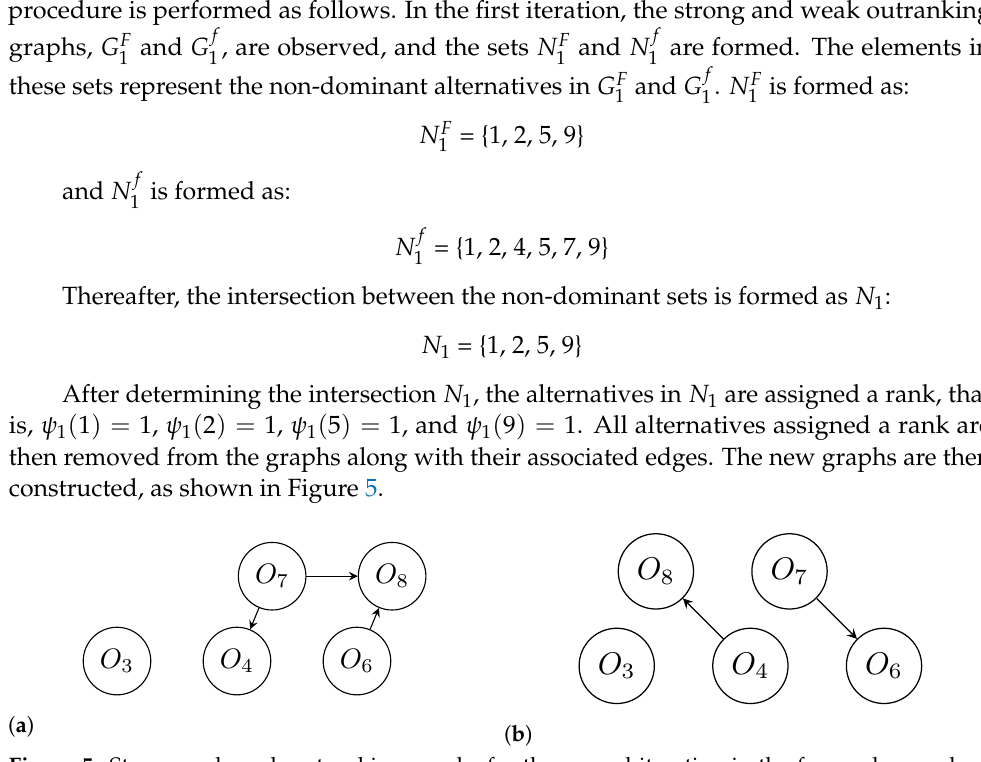
. ( b ) Weak outranking graph G f 2